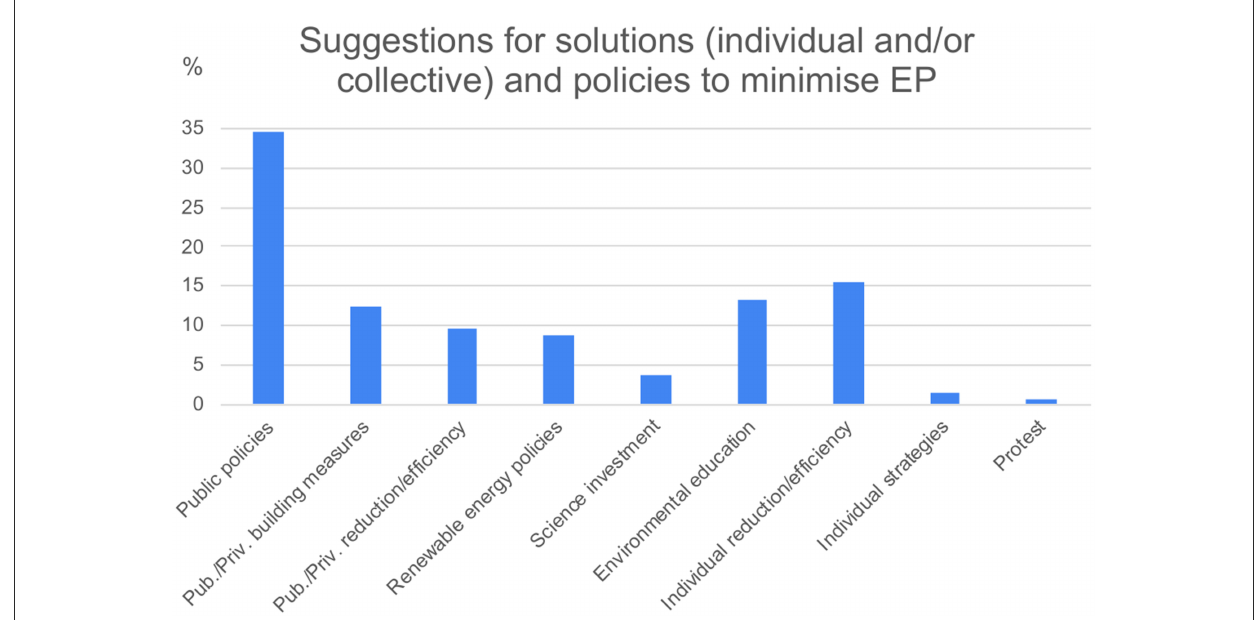
FIGURE7 Answers from 30% of all populations to the question “What solutions (individual and/or collective) and policies do you use/suggest to minimize the problem?”.